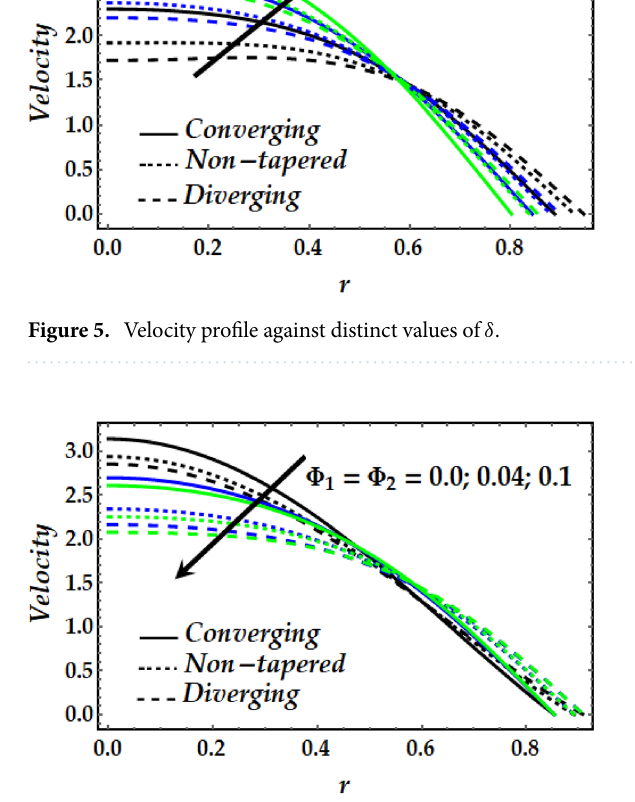
Figure 6. Velocity profile against distinct values of (cid:31) 1 , (cid:31) 2